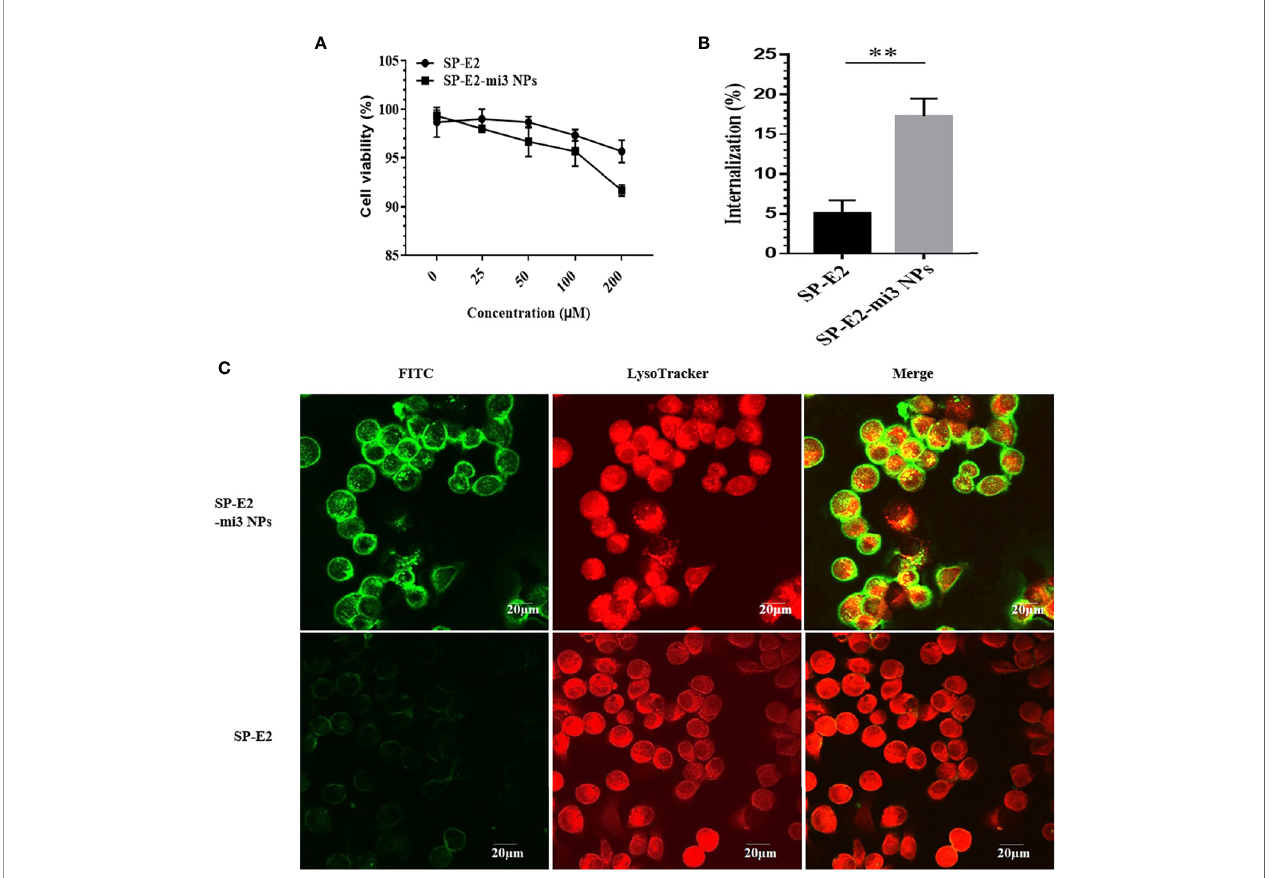
FIGURE 3 | Evaluation of internalization ef fi ciency by PAM/3D4 cells. (A) Cytotoxicity of SP-E2-mi3 NPs or SP-E2 on PAM/3D4 cells at various concentrations after incubation for 24 h. (B) PAM/3D4 cells were incubated with FITC-SP-E2 or FITC-SP-E2-mi3 NPs for 2 h. The internalization ef fi ciency of SP-E2 was determined, and all results were presented from triplicate experiments. NPs counting were calculated by ImageJ. All analyses were performed in triplicate. (C) After exposed to FITC- SP-E2 or FITC-SP-E2-mi3 NPs for 2 h, the binding and internalization of SP-E2-mi3 NPs was analyzed. Signals of SP-E2 or SP-E2-mi3 NPs (green) and LysoTracker (red) were visualized with confocal microscopy. **p < 0.01.